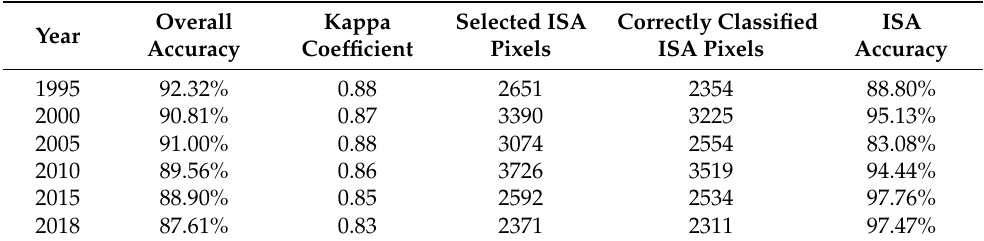
Table 5. Indicators related to ISA classification of land classification confusion matrix in Dongying from 1995 to